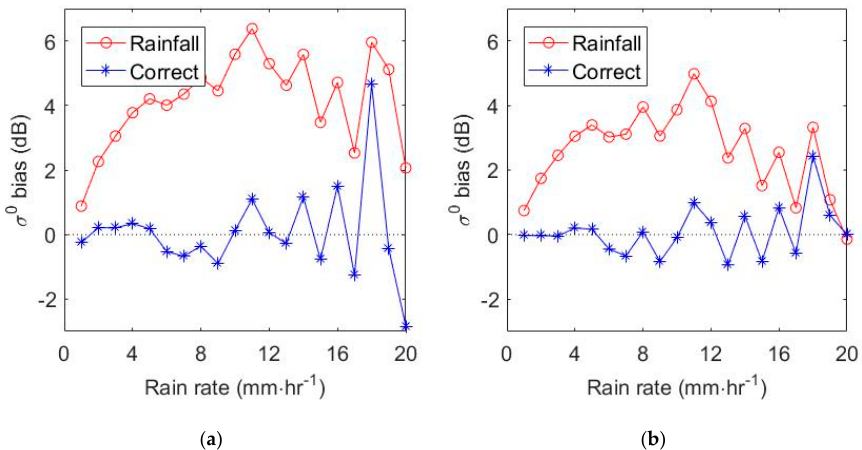
Figure 6. Dependence of σ 0 residual on the SSM/I rain rate. The red circle in the figure is the mean value of deviation of HY-2A measurement σ 0 minus ECMWF model σ 0 , and the blue asterisk is the mean value of deviation of neural network correction σ 0 minus ECMWF model σ 0 . ( a ) for HH polarization; ( b ) for VV polarization.